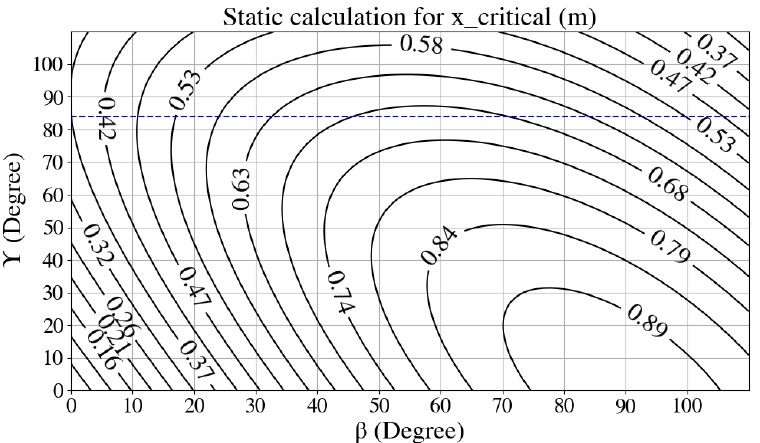
guarantees stability.